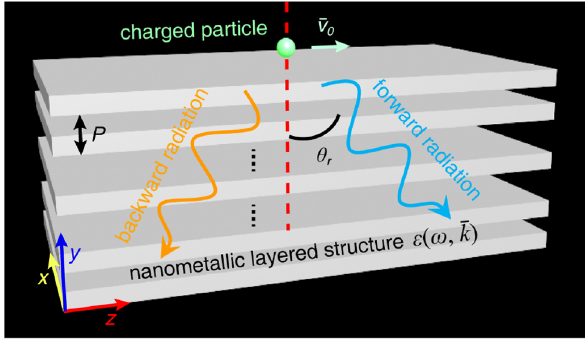
Figure 1: Schematic diagram of Cherenkov radiation in the nanometallic layered structure. A charged particle with the velocity of ¯ v 0 movesonthe top of nanometallic layeredstructurealongthe z - direction, generating longitudinal Cherenkov photons downward. The thicknesses of metal slabs and air slabs are d 1 and d 2 , respectively. The pitch of layered structure is P = d 1 + d 2 . The free- electron response of nonlocal metals is described with the hydrodynamic model as ϵ ( ω , ¯ k ) . Here, the radiation angle of longitudinal Cherenkov photons θ r is de fi ned as the angle between the Poynting power vector and the y -axis. Longitudinal Cherenkov photons are forward-propagating when θ r > 0 and backward- propagating when θ r <